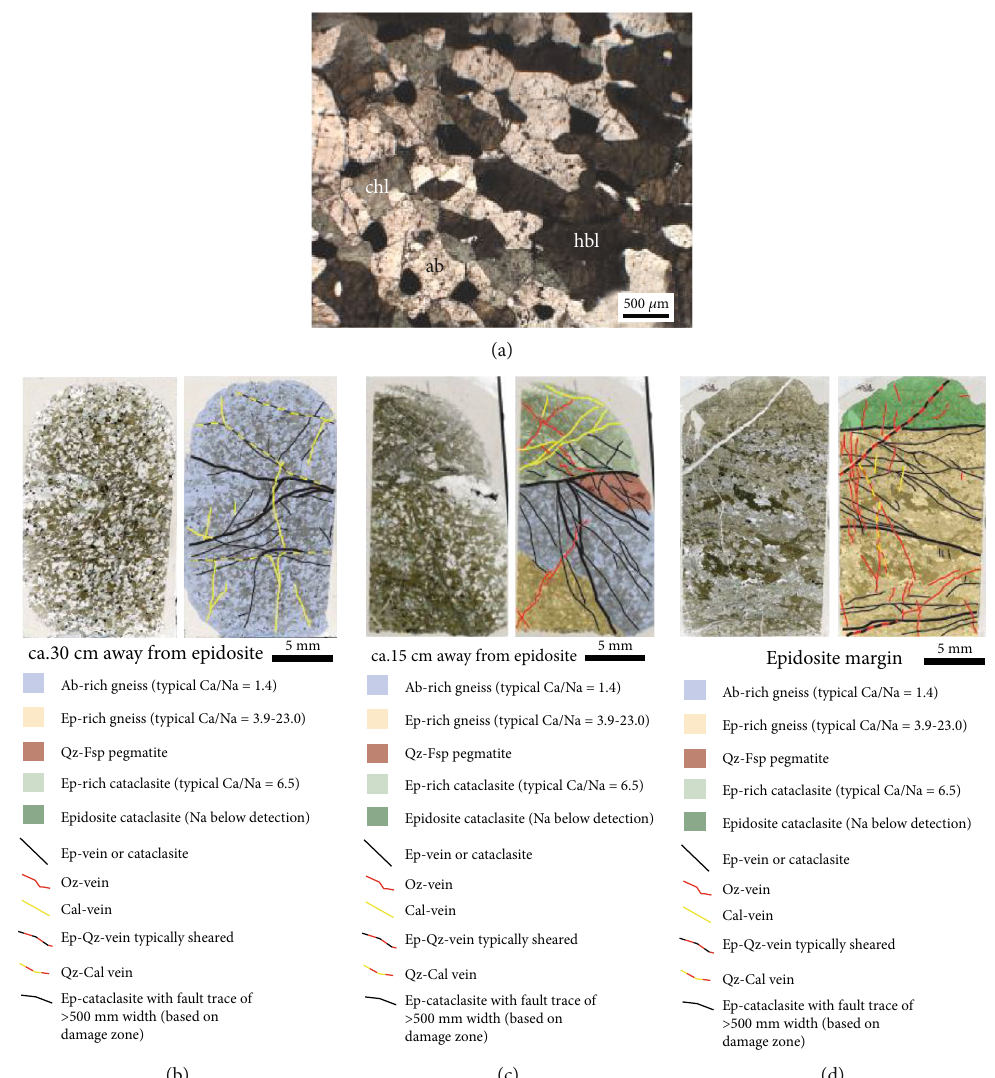
Figure 3: Photomicrographs of thin sections (plane polarized light: PPL). (a) Host metabasic gneiss with granoblastic texture, slightly elongate hornblende (hbl), albite (ab), and chlorite (chl) (abbreviations follow Whitney and Evans [95]); (b) thin section scan (sample G) (left view) and structural, lithological interpretation of texture (right view); (c) thin section scan (sample H) (left view) and structural, lithological interpretation of texture (right view); (d) thin section scan (sample I) (left view) and structural, lithological interpretation of texture (right view). The legend shows the ratio of elemental wt% Ca/Na determined by energy dispersive